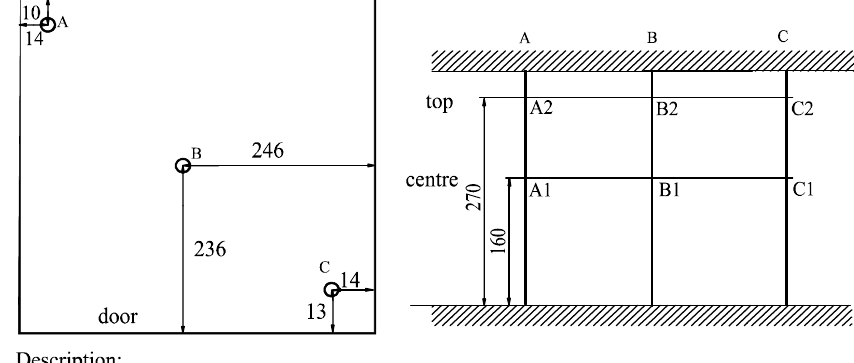
Fig. 5. The arrangement of gas concentration sensors (A1, A2, B1, B2, C1 i C2) in horizontal and vertical